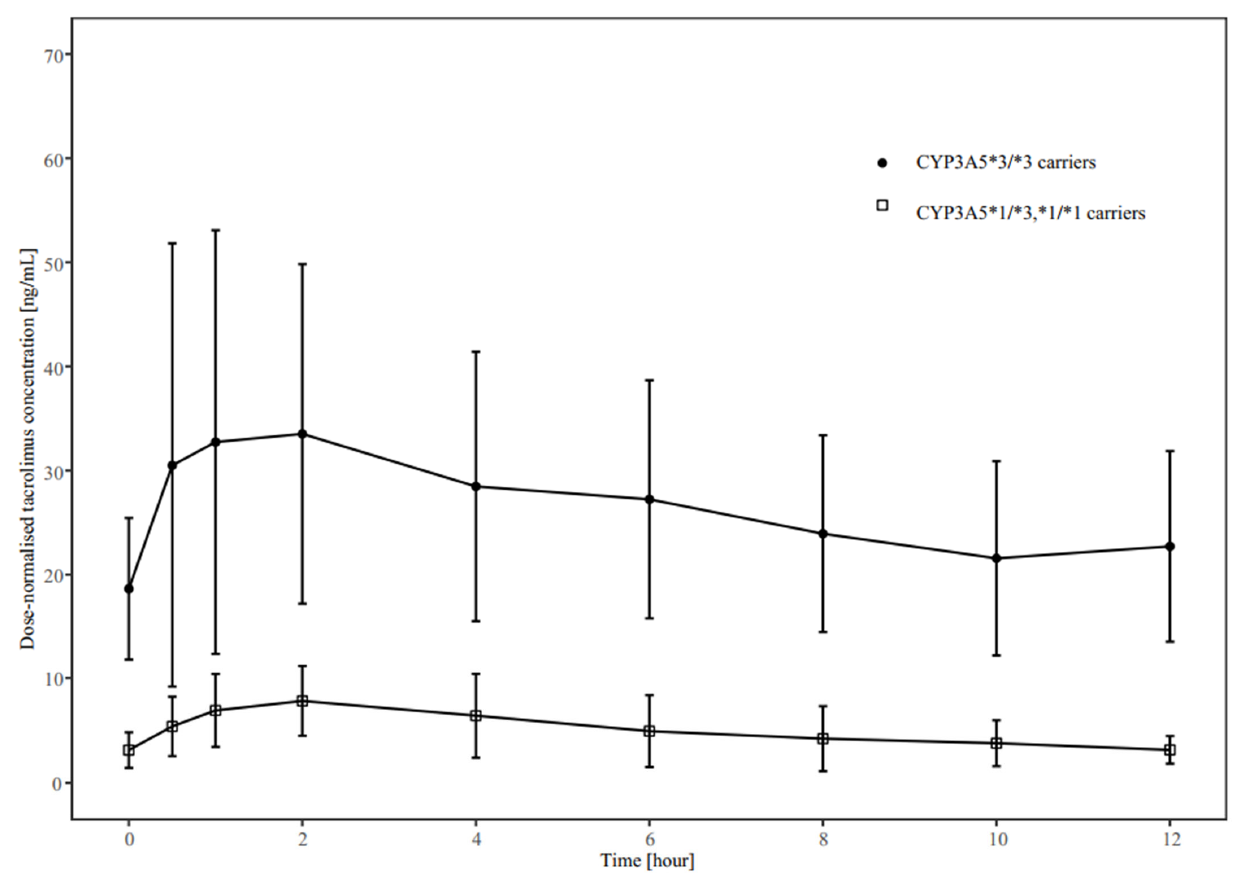
Figure 2. Dose-normalised concentration–time profiles of tacrolimus stratified by CYP3A5 genotype.